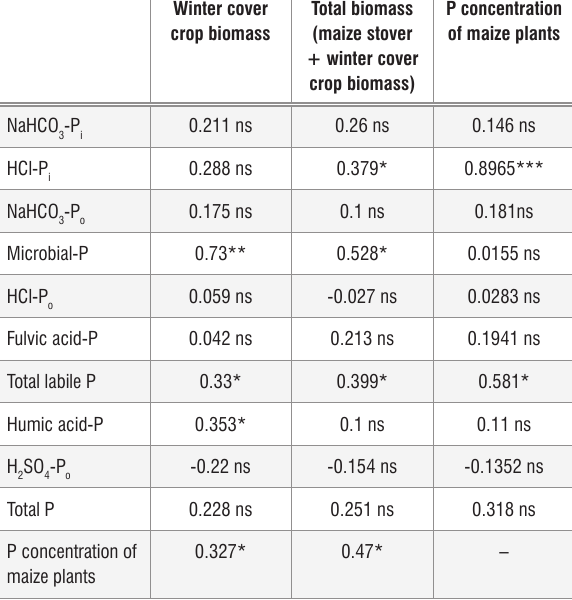
Spearman’s rank correlation matrixes for winter cover crop biomass and maize stover input (summed over 4 years)